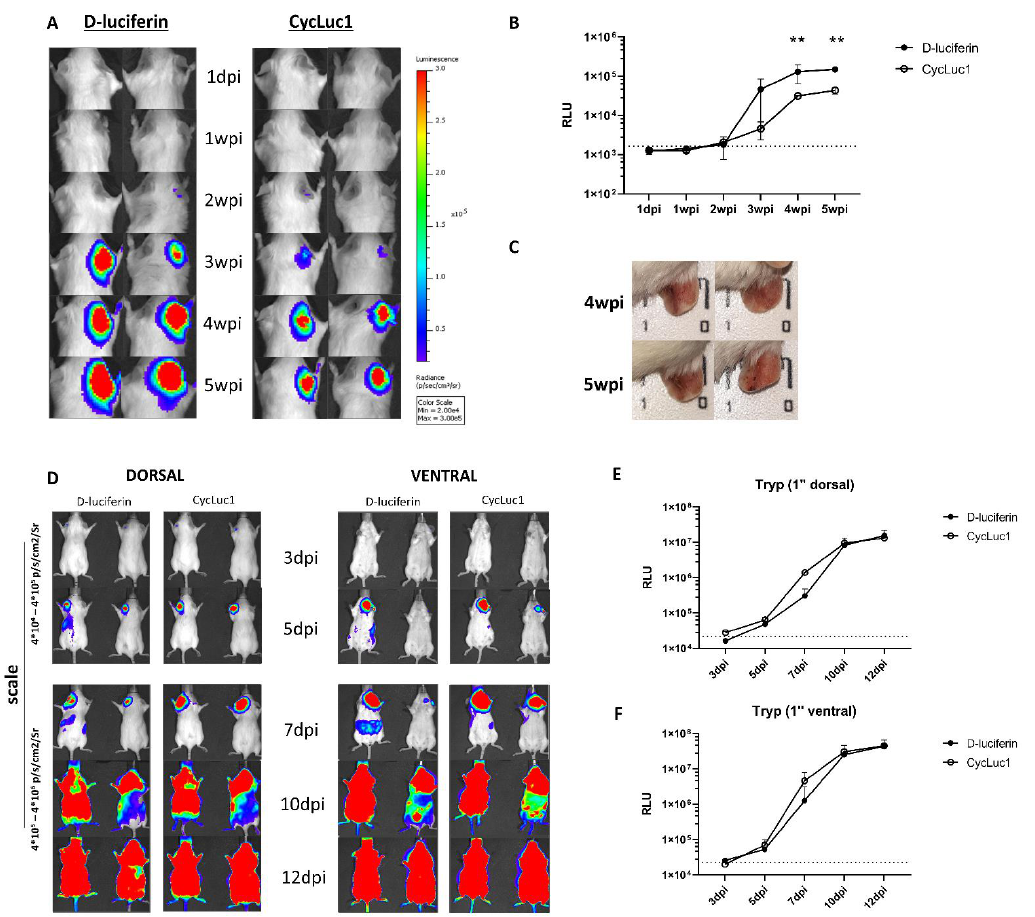
Figure 3. Bioluminescence with D-luciferin and CycLuc1 after sand fly transmission of L. major JISH118 PpyRE9 and tsetse fly transmission of T. brucei brucei AnTAR PpyRE9 in BALB/c or Swiss mice. ( A ) Representative bioluminescent images of BALB/c mice infected with L. major JISH118 PpyRE9 in the right ear via sand fly transmission after administration of D-luciferin (150 mg/kg) and CycLuc1 (7.5 mg/kg); ( B ) Graphic representation of the bioluminescent signal of panel ( A ). Results are expressed as mean ± SD ( n = 3); ( C ) Pictures of the ears of BALB/c mice infected with L. major JISH118 PpyRE9 via sand fly bites showing induced lesions. ( D ) Representative bioluminescent images of Swiss mice infected with T. brucei brucei AnTAR PpyRE9 in the left ear via tsetse fly bites after administration of D-luciferin (150 mg/kg) and CycLuc1 (7.5 mg/kg); ( E , F ) Graphic representation of the total body bio-luminescent output of ( D ). Results are expressed as mean relative luminescence units (RLU) [p/s/cm2/Sr]) ± SD (** p ≤ 0.0 1) ( n = 2). (dpi: days post infection; wpi: weeks post infection).